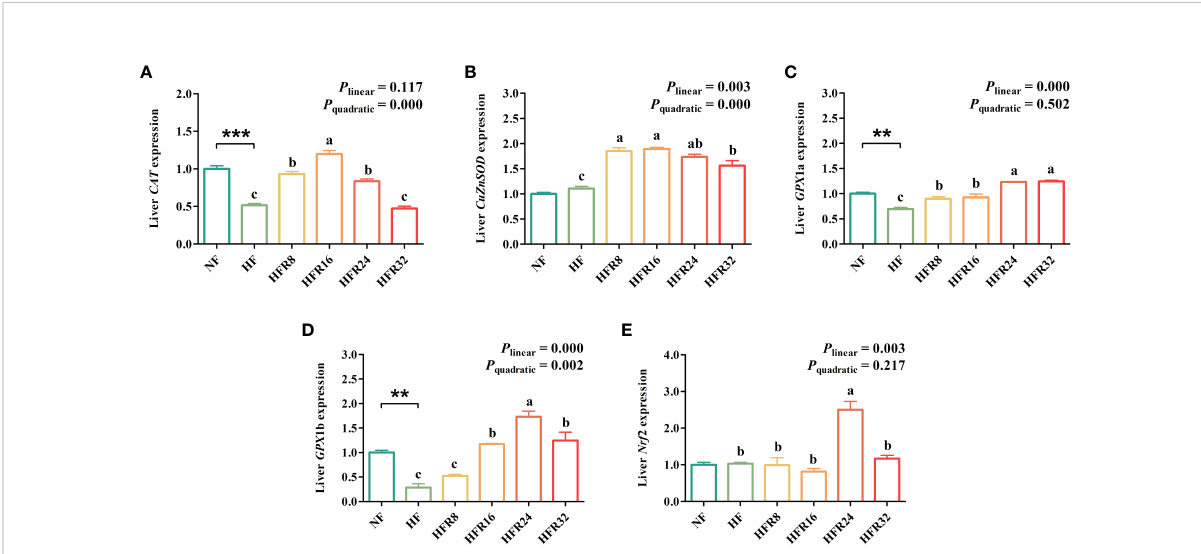
FIGURE 3 Effects of resveratrol supplementation on the hepatic antioxidant-related gene expression in common carp ( Cyprinus carpio ). (A) catalase (CAT); (B) copper, zinc superoxide dismutase (CuZnSOD); (C) glutathione peroxidase 1a (GPx1a); (D) glutathione peroxidase 1b (GPx1b); (E) nuclear factor erythroid 2-related factor 2 (Nrf2). Data are presented as means ± SEM. “ * ” represented statistical difference between the NF group and the HF group using student ’ s t-test (** P < 0.01 or *** P < 0.001). “ abc ” represented statistical difference among different RSV levels in the HF diet. P -values indicated a linear and quadratic to dietary RSV levels using orthogonal polynomial analysis. Bars with different superscripts are statistically different ( P < 0.05, n = 3).